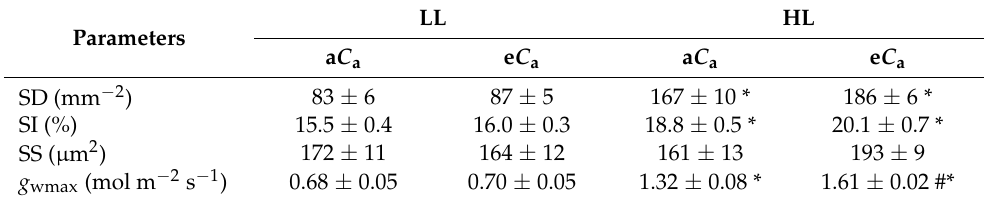
Table 3. The effect of light intensity [low (LL) or high (HL) light] and CO 2 supply [ambient (a C a ) or elevated (e C a )] on stomatal density (SD), stomatal index (SI), stomatal size (SS), and maximum (theoretical) stomatal conductance to water vapor ( g wmax ) of coffee plants. When shown, asterisk (*) indicates differences between light regimes within the same CO 2 supply, whereas hash (#) indicates differences between CO 2 treatments within the same light regime ( p ≤ 0.05, t test, n = 6 ± SE). LL HL Parameters a C a e C a a C a e C a SD (mm − 2 ) 83 ± 6 87 ± 5 167 ± 10 * 186 ± 6 * SI (%) 15.5 ± 0.4 16.0 ± 0.3 18.8 ± 0.5 * 20.1 ± 0.7 * SS ( µ m 2 ) 172 ± 11 164 ± 12 161 ± 13 193 ± 9 g wmax (mol m − 2 s − 1 ) 0.68 ± 0.05 0.70 ± 0.05 1.32 ± 0.08 * 1.61 ± 0.02